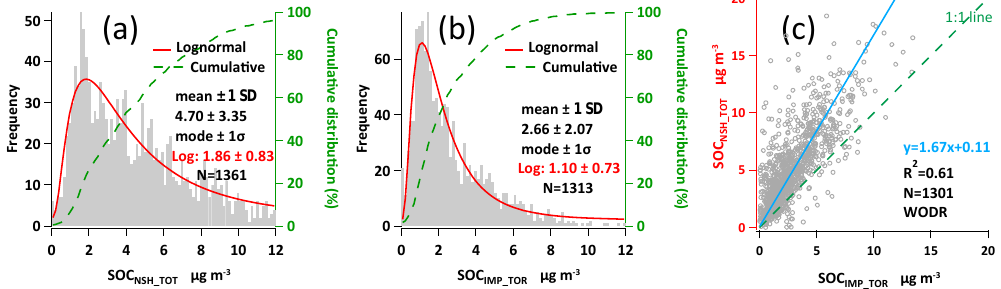
Figure 10. Comparison of SOC by NIOSH and IMPROVE. (a) SOC estimation from NIOSH TOT data. (b) SOC estimation from IMPROVE TOR data. (c) The relationship between SOC NSH_TOT and SOC IMP_TOR .